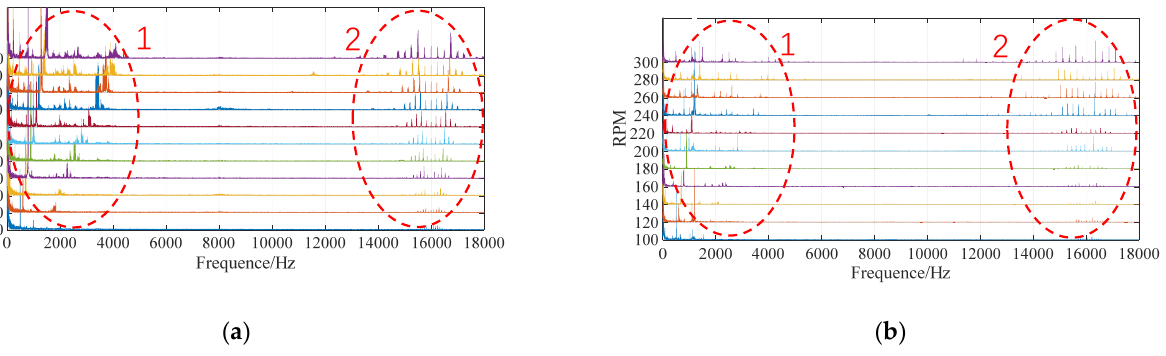
Figure 10. Testing results. Waterfall of the acoustic noise of the motor: ( a ) half-step subdivision mode in loaded operation; ( b ) sensorless FOC mode in loaded operation.